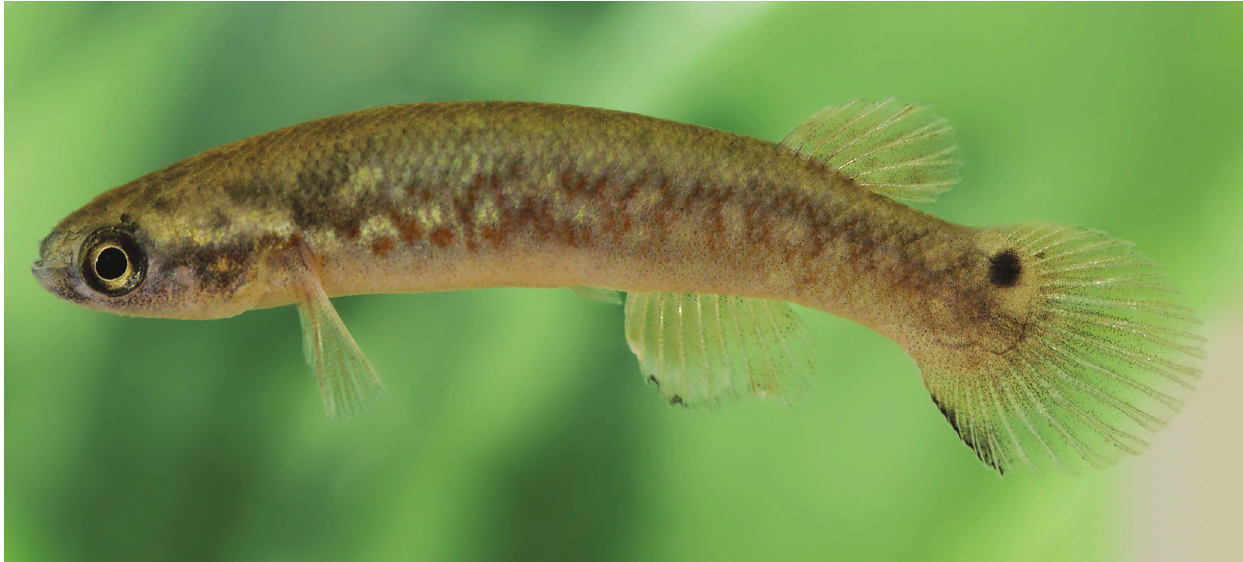
Fig. 1. Kryptolebias hermaphroditus , male, UFRN 3774, 30.1 mm SL (three days after sampling); Ceará-Mirim River estuary, Extremoz, Rio Grande do Norte,